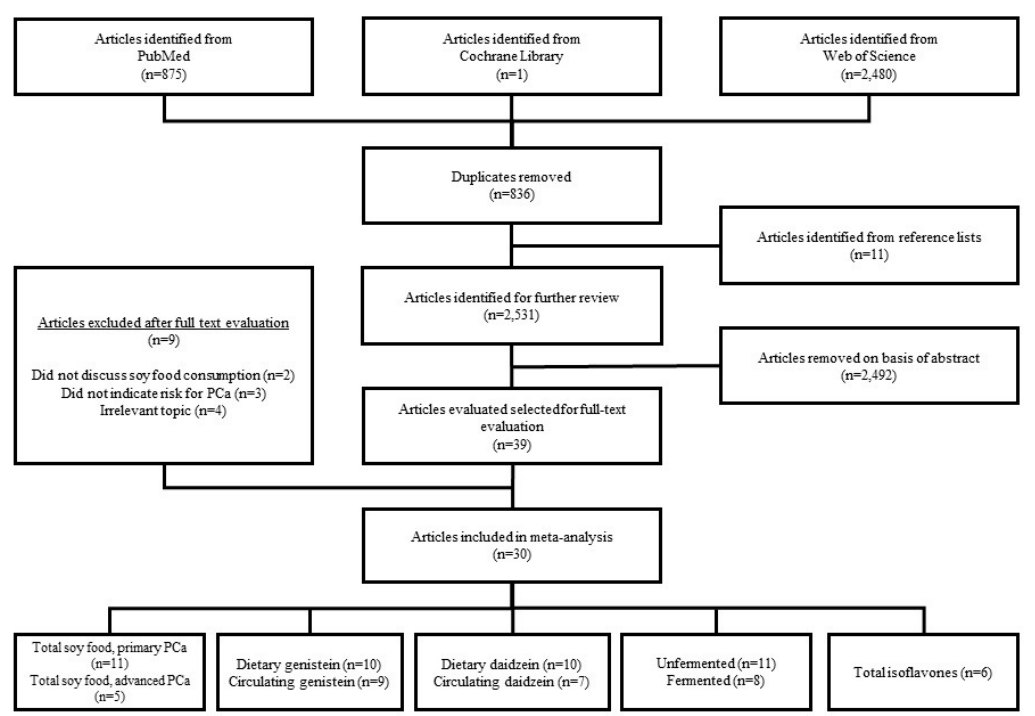
Figure 1. Literature search and study selection flow chart.